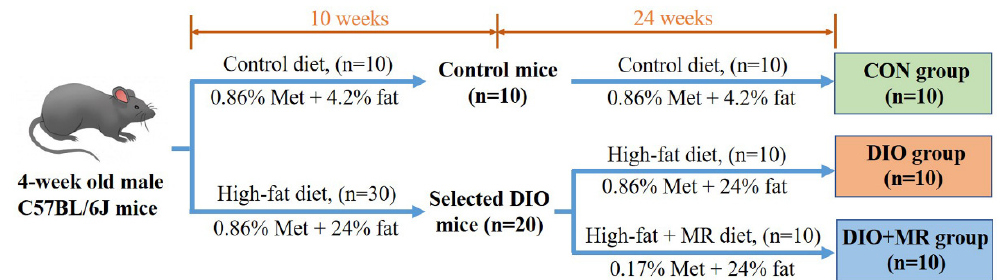
Figure 1. The animal experiment design and schedule of the experiment. Four-week old male C57BL/6J mice ( n = 40) were first randomly divided into two groups. One group was fed the control diet ( n = 10, the diet contained 0.86% Met and 4.2% fat) as a control; the other group was fed the high-fat diet ( n = 30, the diet contained 0.86% Met and 24% fat) to establish diet-induced obese (DIO) mouse models. After 10 weeks of the high-fat diet treatment, given the possibility of the obesity- resistant mice (the lower tertile of body weight, n = 10, these mice were excluded from this study and used in an experiment related to obesity resistance) according to our previous study, 20 heavier mice were selected as DIO mice. Then the DIO mice were randomly divided into two groups: (1) the DIO group ( n = 10), the mice were still fed the same high-fat diet (0.86% Met, 24% fat) for 24 weeks; (2) the DIO + MR group ( n = 10), the mice were fed a different high-fat diet (0.17% Met, 24% fat) for 24 weeks. The control group (CON group, n = 10) mice continued to receive the same control diet (0.86% Met and 4.2% fat) for 24 weeks.